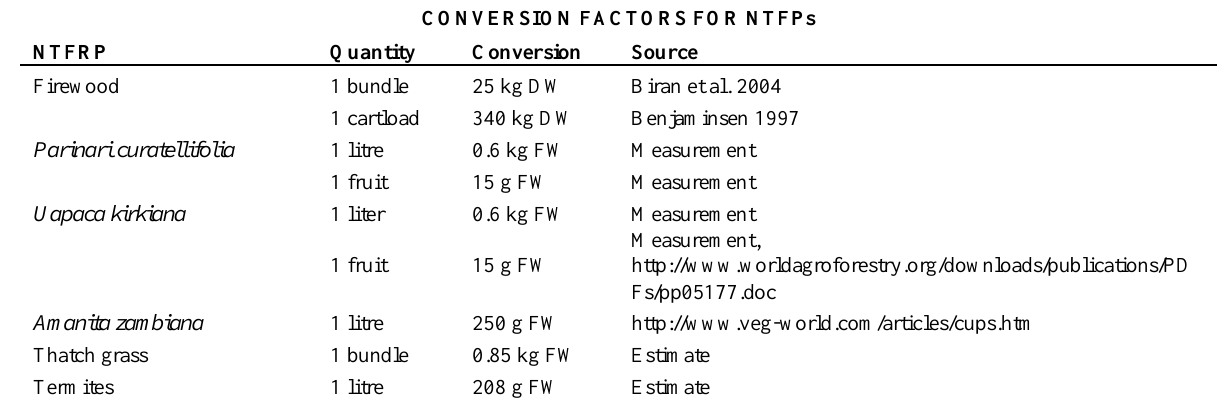
Table A2.2: Conversion factors for